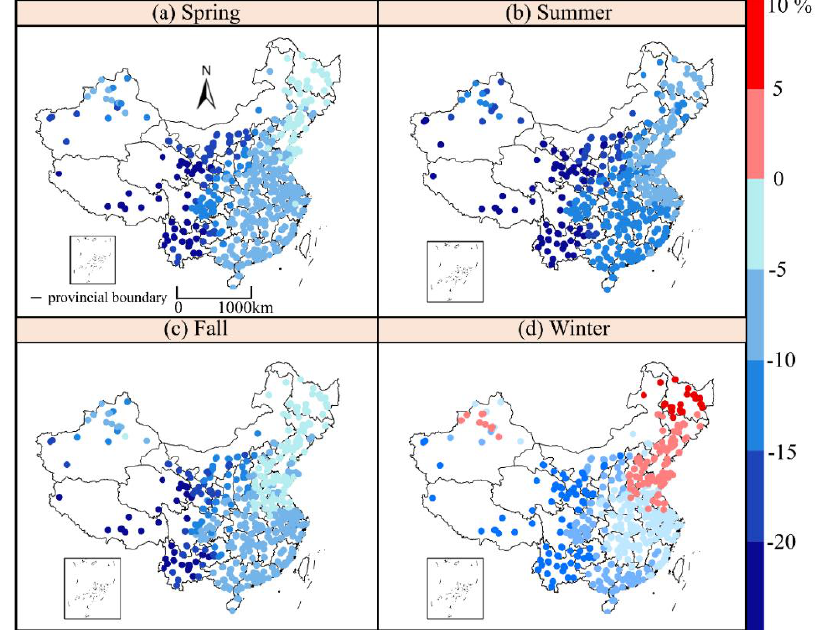
Figure 2. The percentage change of PM 2.5 in four seasons. The percentage change of PM 2.5 concentrations at the national air quality monitoring stations in ( a ) spring, ( b ) summer, ( c ) fall, and ( d ) winter across Mainland China (September 2017–August 2018), due to the monitoring protocol change from standard conditions (298 K and 1013.25 hPa) to actual conditions (i.e., actual atmospheric pressure and temperature).